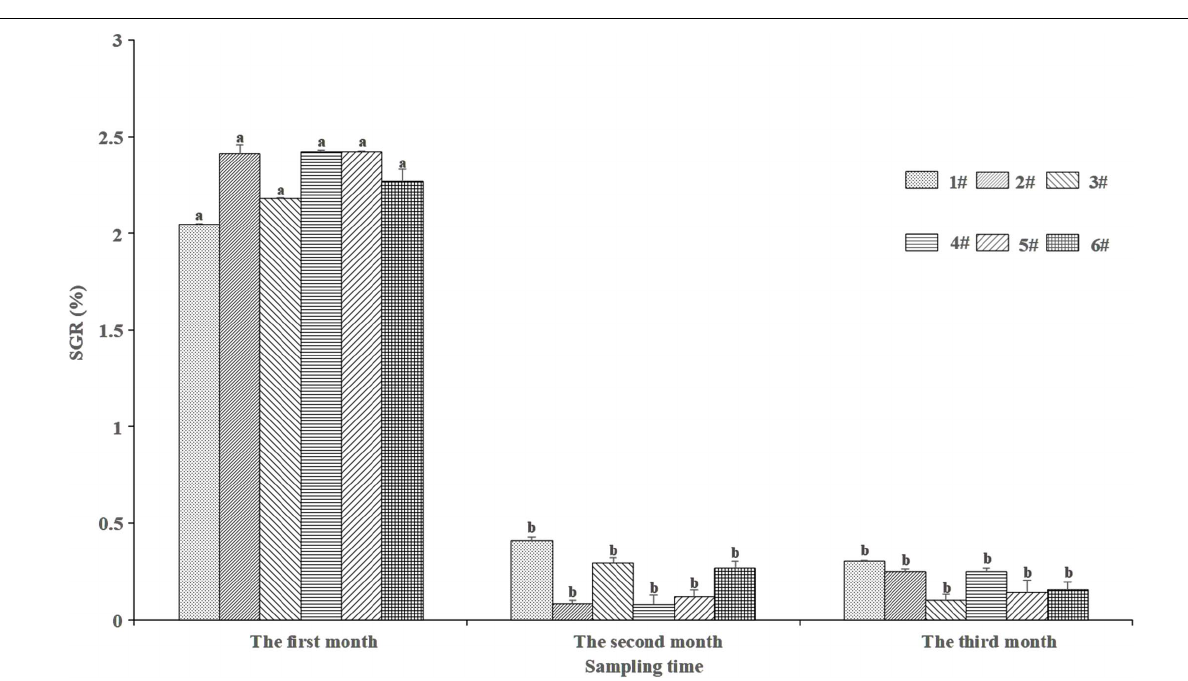
sediments (F = 15.19, p < 0.05), and the sediment had a significant effect on the density of larvae (F = 2.897, p < 0.05), but the interaction between them had no significant effect on the